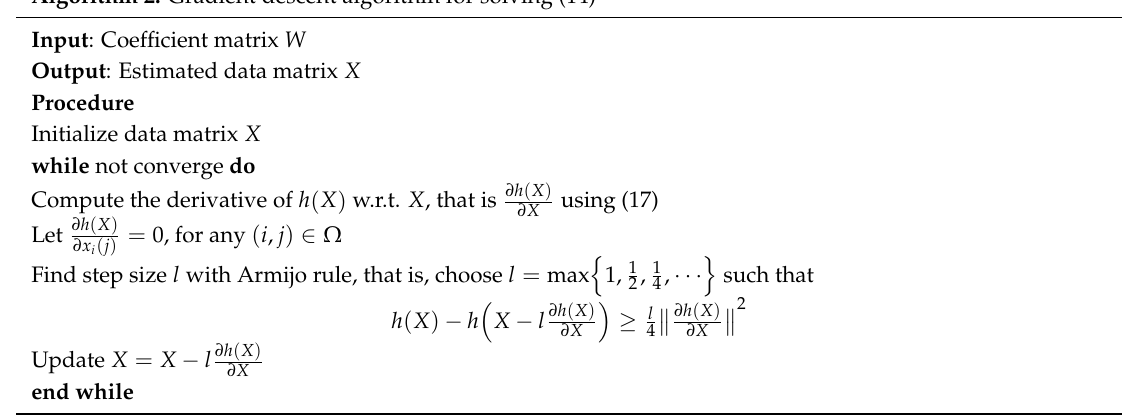
Algorithm 2. Gradient descent algorithm for solving